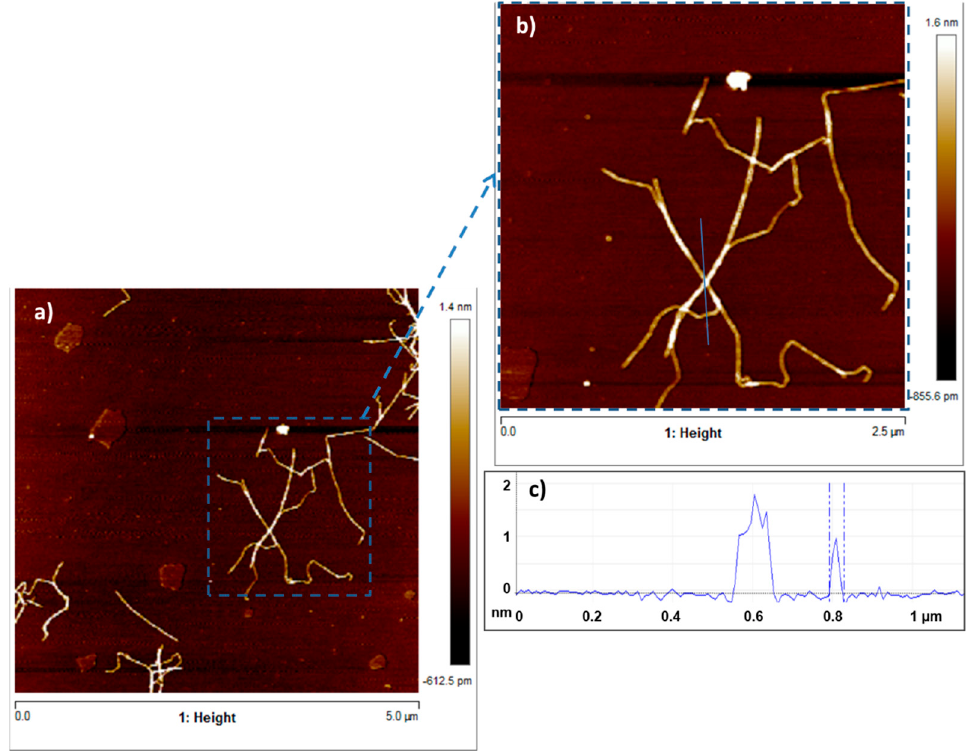
Figure 3. AFM images of CNFs ( a , b ) and depth distribution of a cross section of the AFM image ( c ).